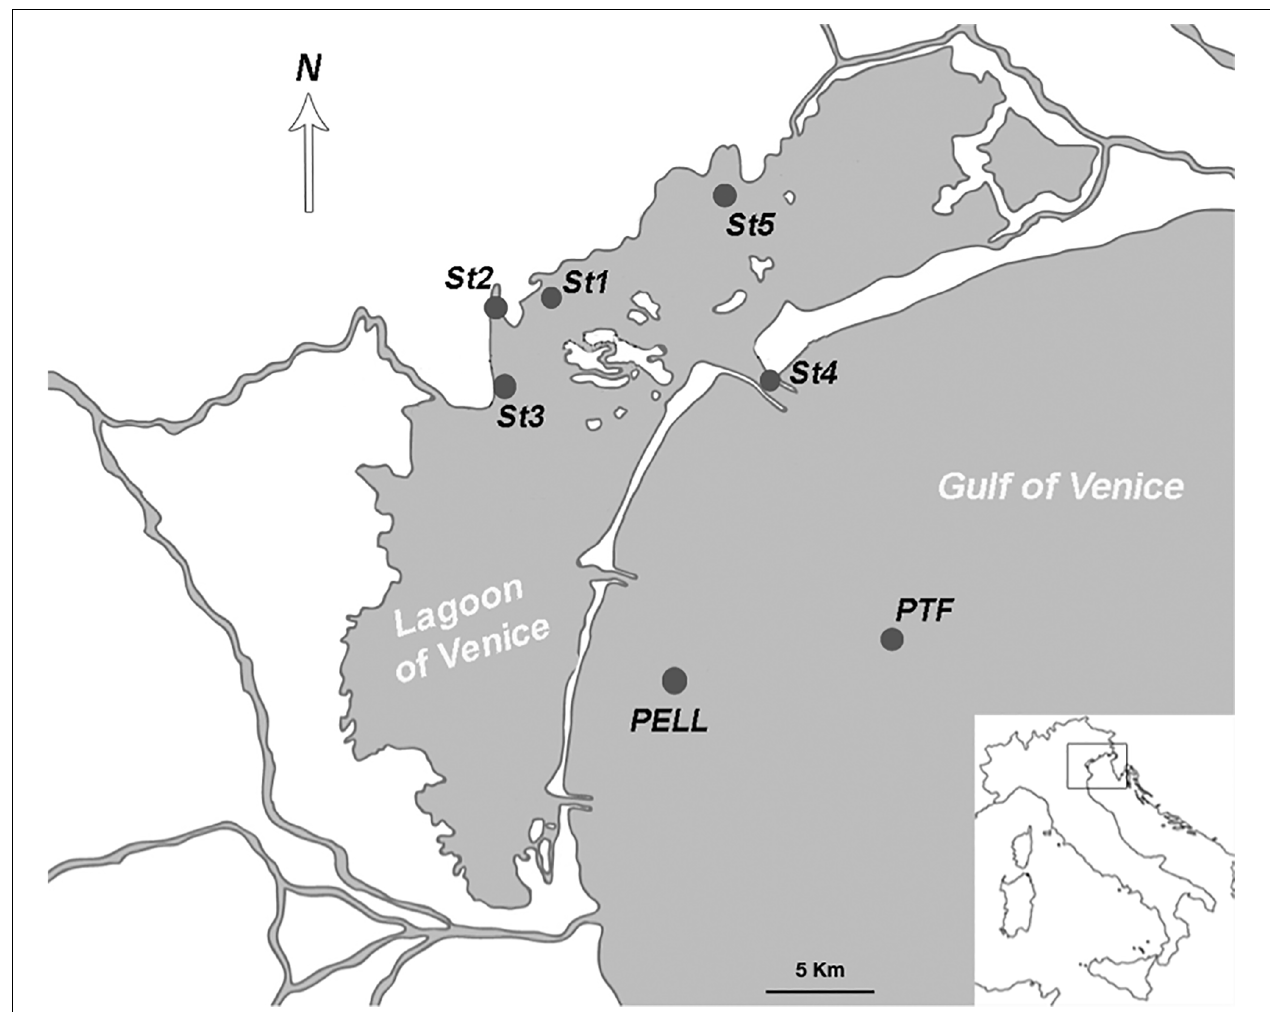
FIGURE 1 | The study area with the seven sampling